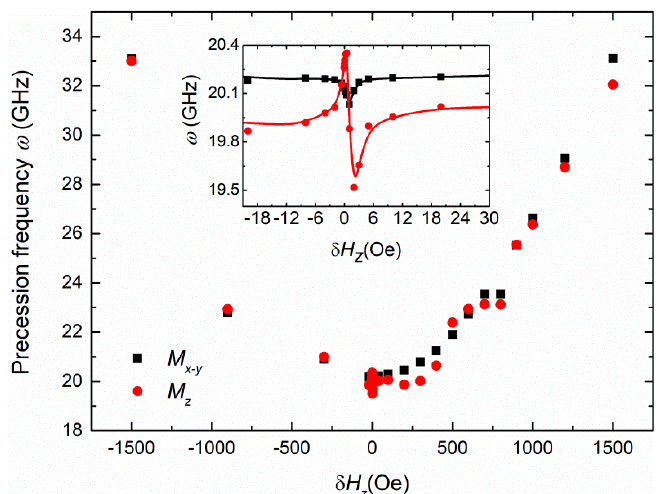
Figure 5. (Color online) LLG simulation of magnetization precession frequency as a function of the modulated value of out-of-plane magnetic anisotropy field ( δ H z ) for the annealed compressively-strained (Ga,Mn)As film. The inset shows details of precession frequency changes near zero field.